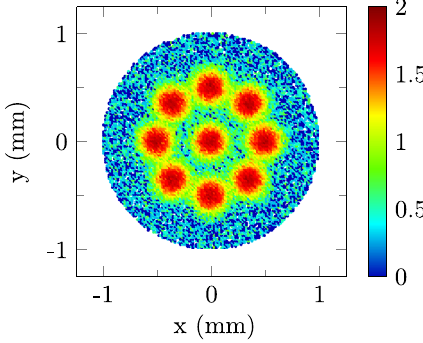
FIG. 11. Density log plot of the cross-section of the initial configuration of ten beamlets each consisting of 10 4 electrons Gaussian distributed, and surrounded by a halo of 2 × 10 4 uniformly distributed